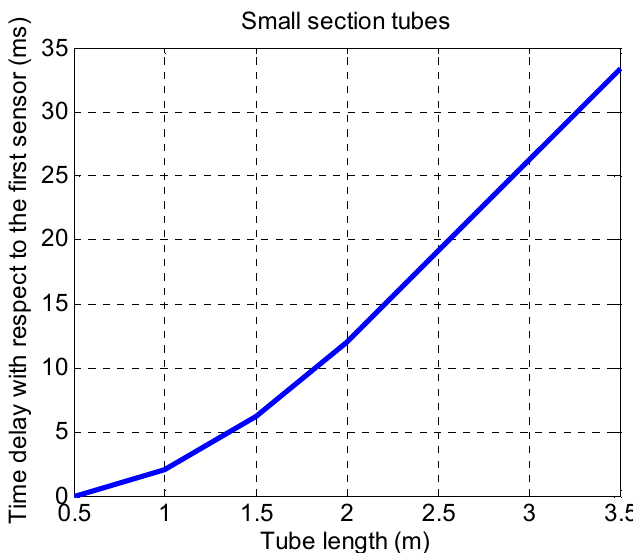
Figure 13. Relationship between the length of the tube and the delay with respect to the first sensor.